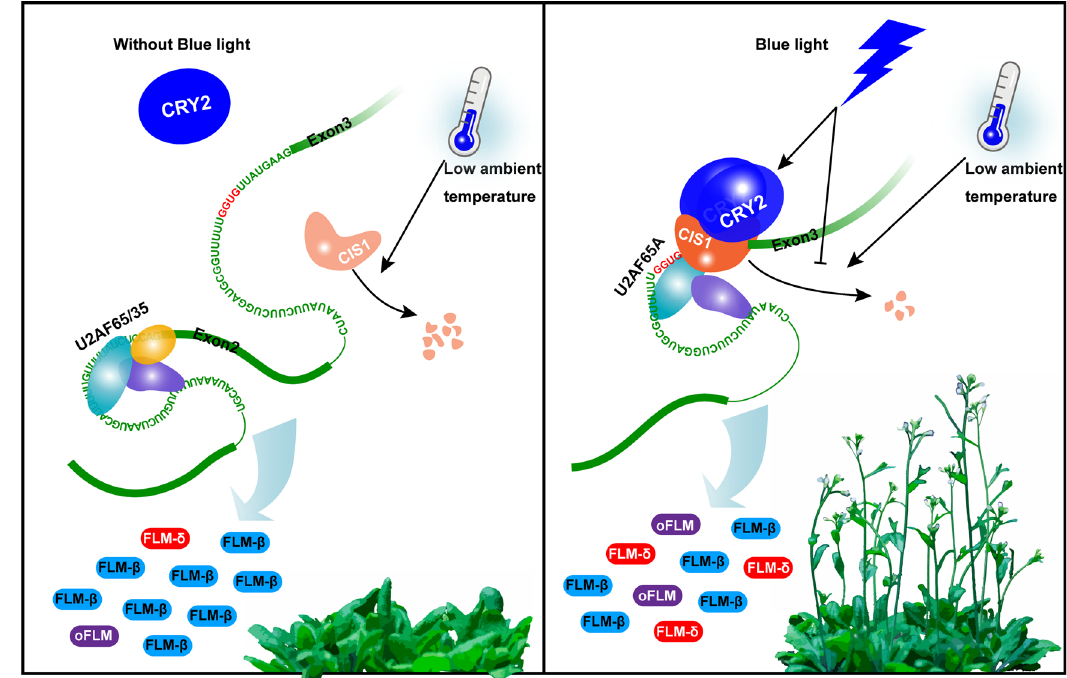
Fig. 7 | A hypothetical model for blue-light regulation of thermosensory fl ow- ering via the CRY2 – CIS1 – FLM signaling pathway. At low ambient temperatures without bluelight,CRY2isinactive,CIS1proteinisunstable, the 3 ʹ splice siteofthe second FLM intron is a weak AS site because of the G tract sequence, leading to more accumulation of FLM β . When there is blue light, CIS1 protein is stabilized;